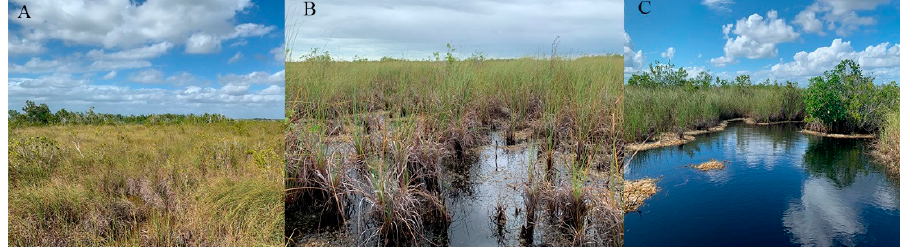
Figure 3. Photos from a graminoid dominated marsh in the coastal Everglades showing the major wetland types mapped in this study; ( A ) high-density, graminoid marsh dominated by Cladium jamaicense with a tree island dominated by mangrove spp. in the background; ( B ) low-density graminoid marsh interspersed with open water; ( C ) an unvegetated open water pond bordered by Cladium jamaicense and the scrub Rhizophora mangle .